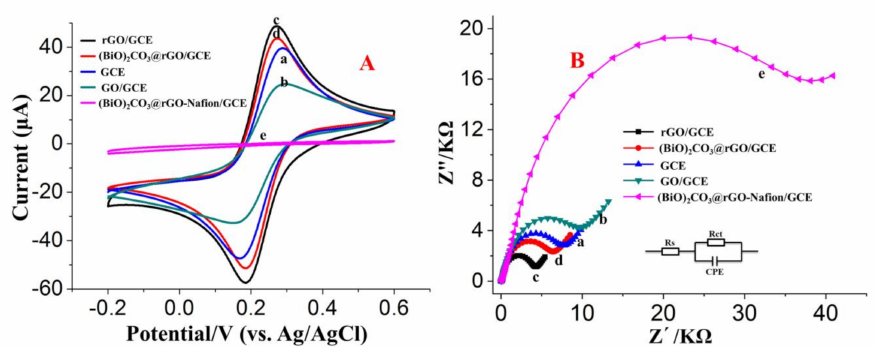
Figure 5. Cyclic voltammograms ( A ) and Nyquist plots of electrochemical impedance spectra ( B ) of 5 mM [Fe(CN) 6 ] 3 − / 4 − in 0.1 M KCl: bare GCE ( a ), GO / GCE ( b ), rGO / GCE ( c ), (BiO) 2 CO 3 -rGO / GCE ( d